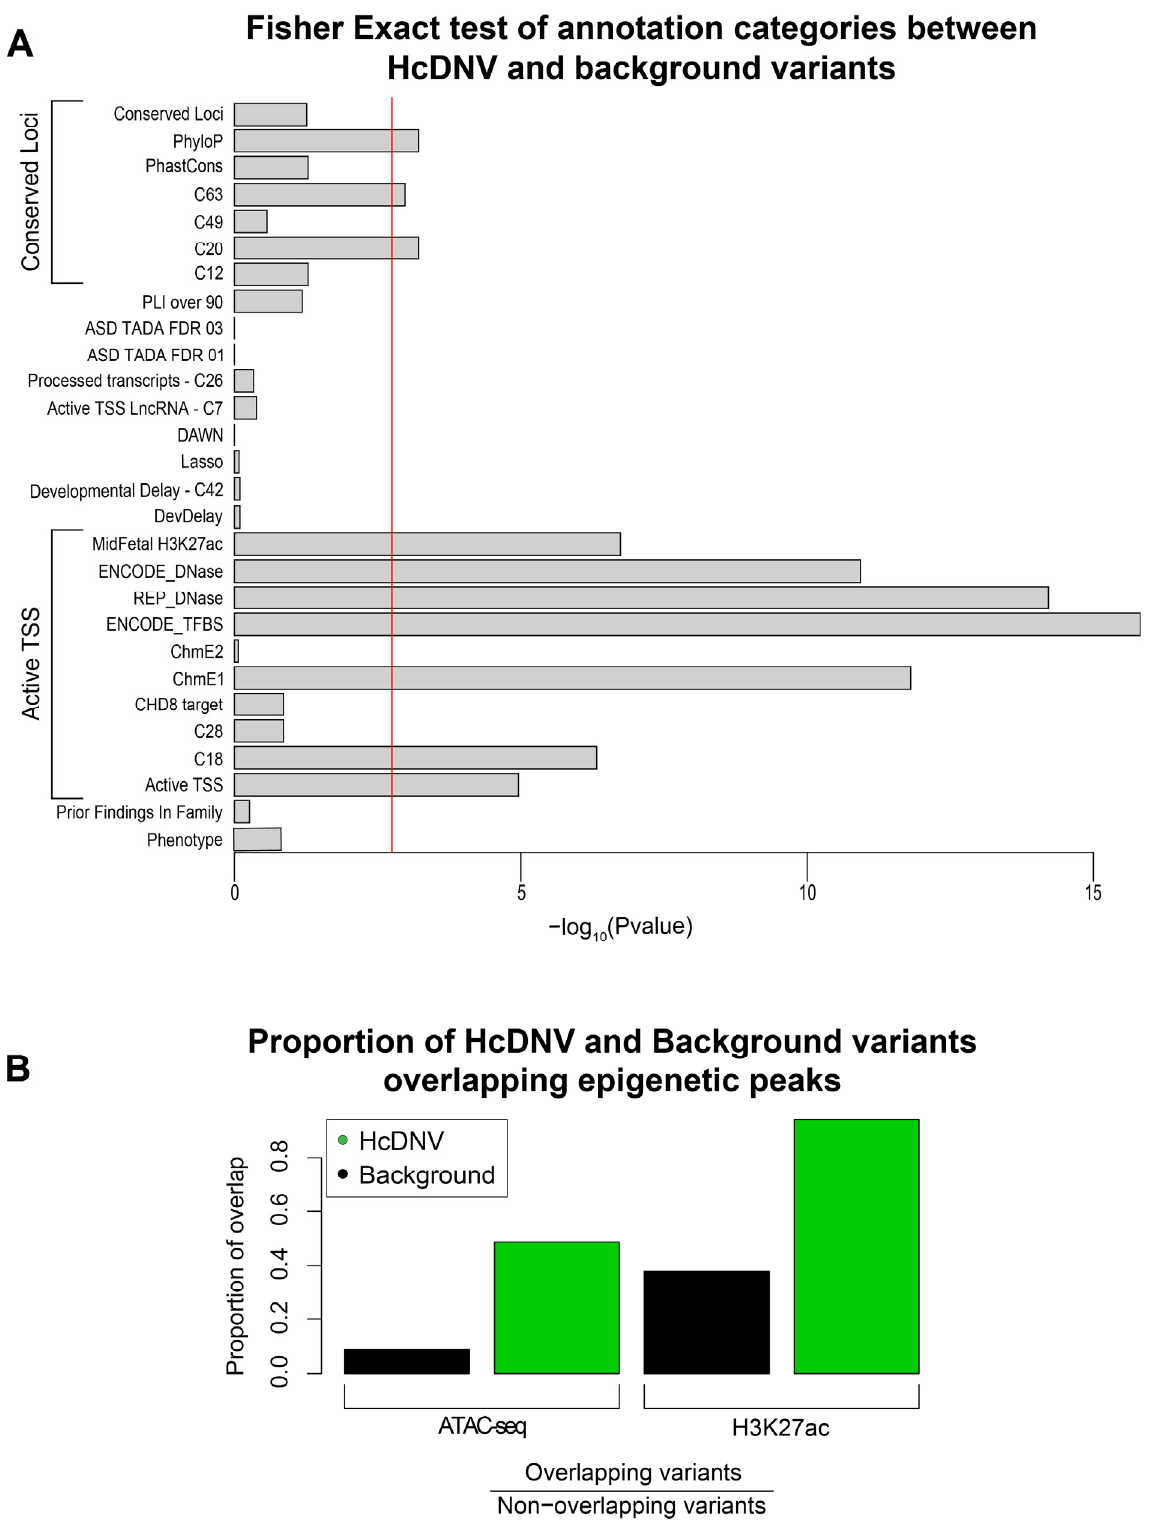
Figure 3. Characterization of variant involvement in regulatory and epigenetic regions. ( A ) Barplot of Fisher’s exact p -values comparing the proportion of HcDNV and background variants found in each annotation category. The red line indicates the Bonferroni multiple testing-corrected p -value threshold. ( B ) Barplot of the proportion of overlap of HcDNV and background variants with H3K27ac and ATACseq peaks. ATACseq p -value = 5.4 × 10 − 18 ; H3K27ac p -value = 4.0 × 10 − 8 .